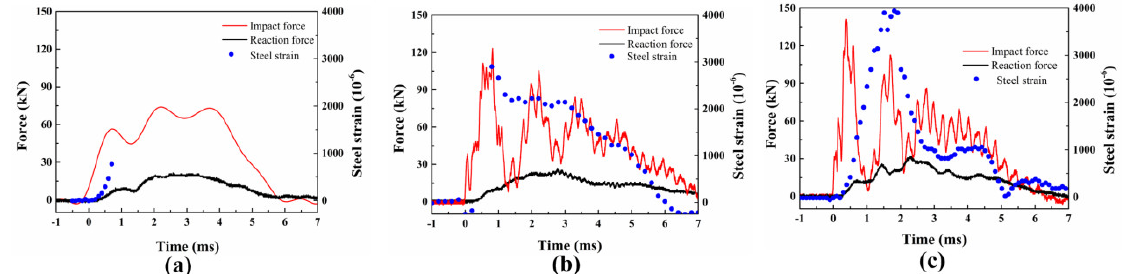
Figure 11. The experimental results under ( a ) 0.989 m/s; ( b ) 1.71 m/s; and ( c ) 2.21 m/s.